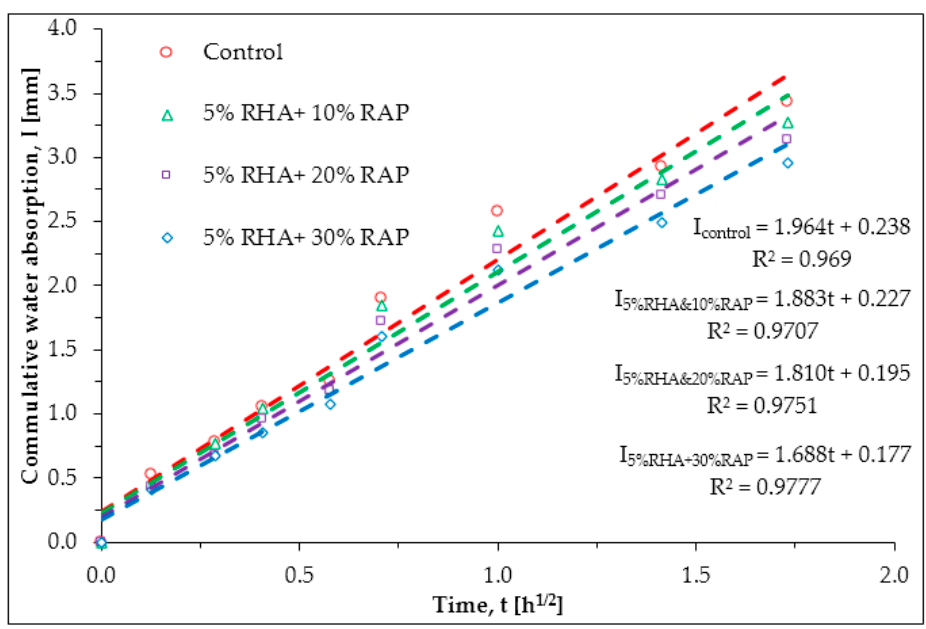
Figure A3. Cumulative water absorption by 5% RHA and (10–30) % RAP-inclusive concrete.